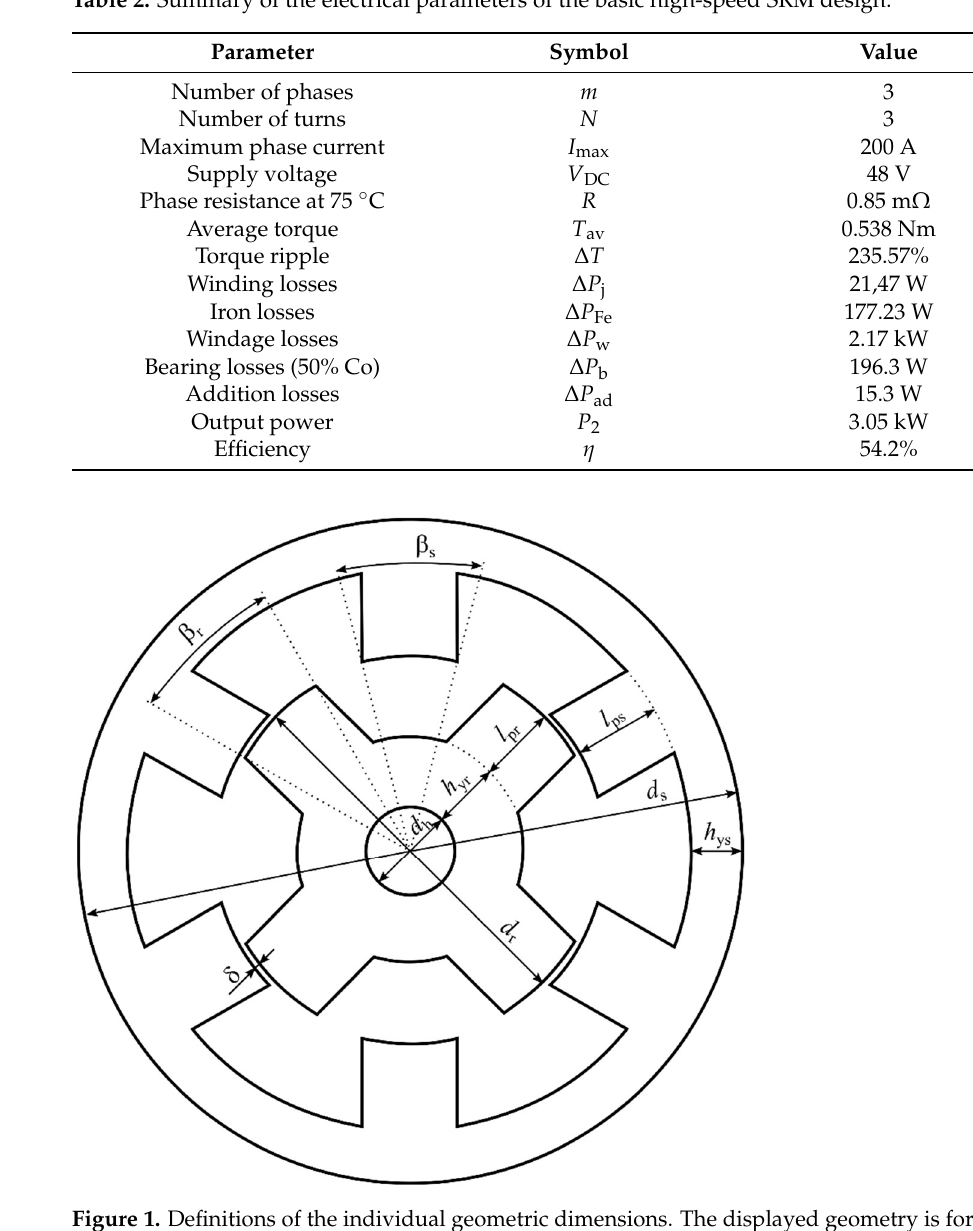
Figure 1. Definitions of the individual geometric dimensions. The displayed geometry is for illus- tration only; i.e., the values of individual dimensions do not correspond to the values in the